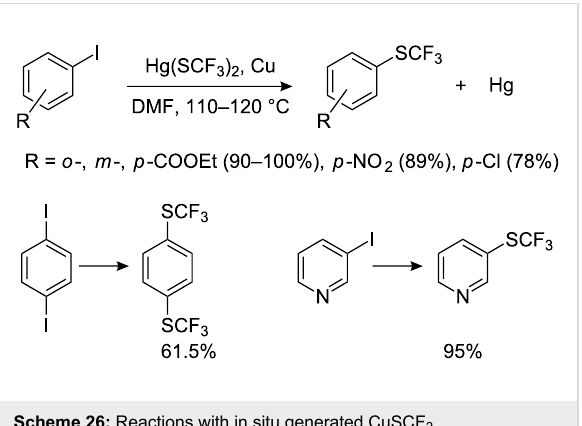
Scheme 26: Reactions with in situ generated CuSCF 3